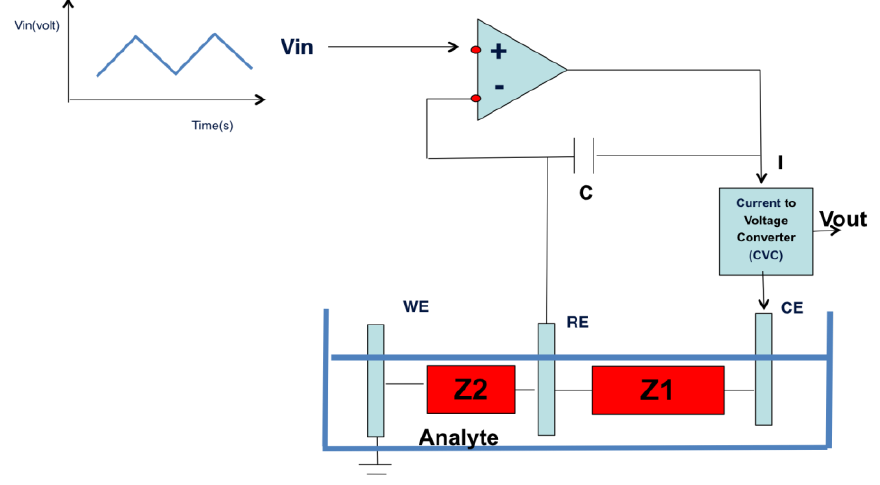
Figure 1. Electronic interface for liquid sensor system. The input signal is a triangular function. The output signal is measured by the working electrode and transduced in an output current by an opportune